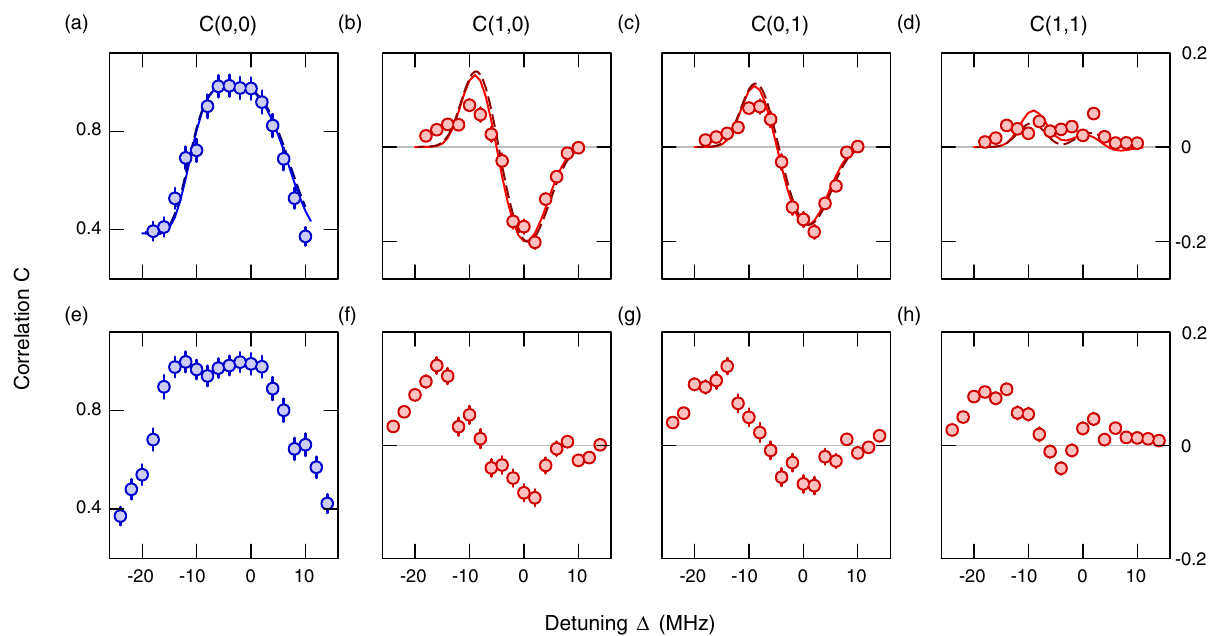
FIG. 2. Sudden quench dynamics. (a) – (d) Spin correlations after a sudden quench with Ω T ¼ 0 . 50 ð 2 Þ π [ Ω ¼ 2 π × 4 . 1 ð 1 Þ MHz] at various detunings Δ . The correlators shown are (a) C ð 0 ; 0 Þ ; (b) C ð 1 ; 0 Þ ; (c) C ð 0 ; 1 Þ ; and (d) C ð 1 ; 1 Þ . For comparison, we show the fits to dynamics computed with NLCE (solid line) and exact diagonalization on a 4 × 4 lattice with open boundary conditions (dashed line). (e) – (h) Spin correlations after a longer quench of Ω T ¼ 2 . 97 ð 7 Þ π [ Ω ¼ 2 π × 5 . 3 ð 1 Þ MHz] at various